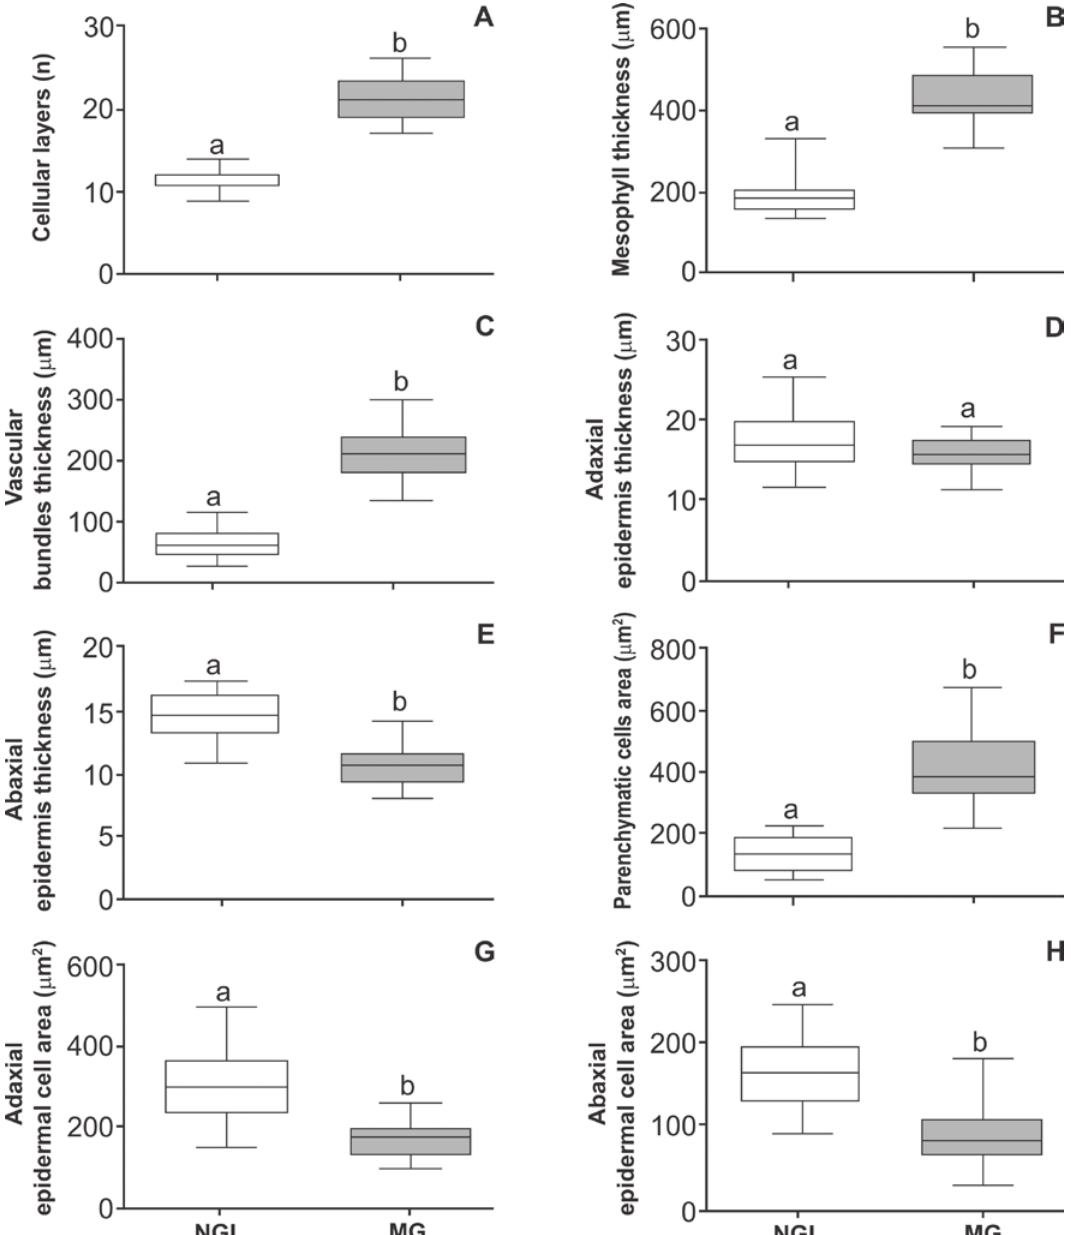
Fig. 4 - Cytological and histometrical analyses of cross sections of non-galled leaves (NGL) of Schinus polygamus and mature galls (MG) of Calophya duvauae . Bars followed by the same letters are not significantly different (Kruskal-Wallis test, followed by Dunn’s multiple comparison tests; α = 0.05). Box plots represent the medians and corresponding